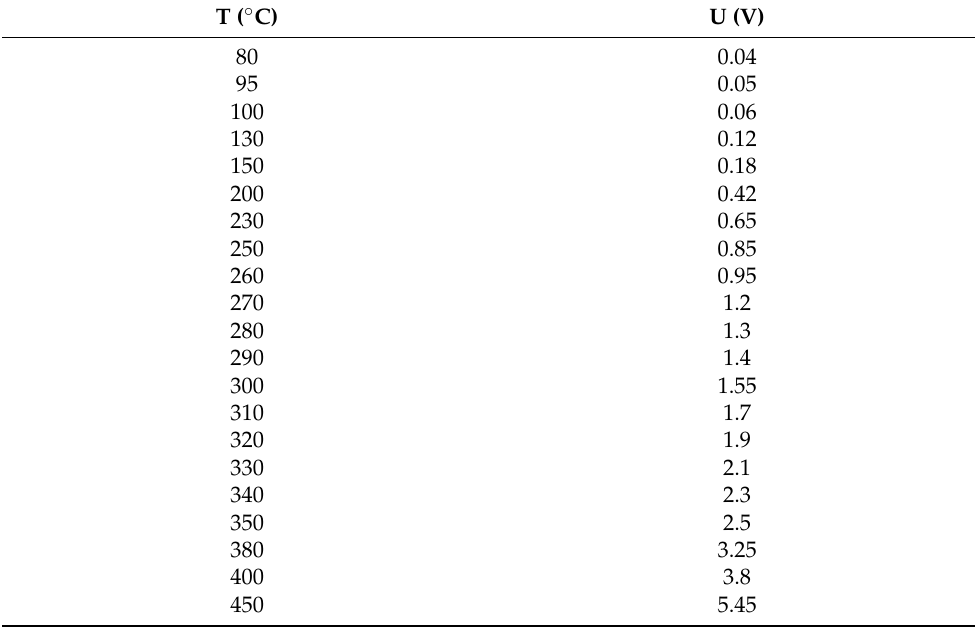
Table 2. Calibration data set by